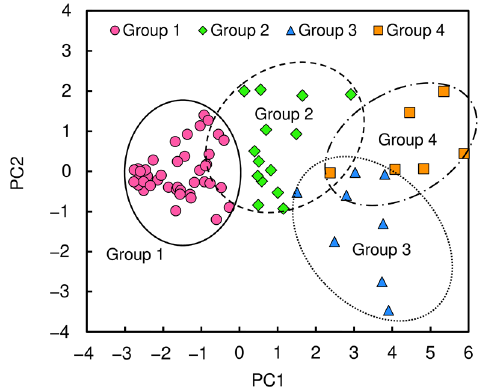
Figure 9. Scatter plot of PC1 against PC2.